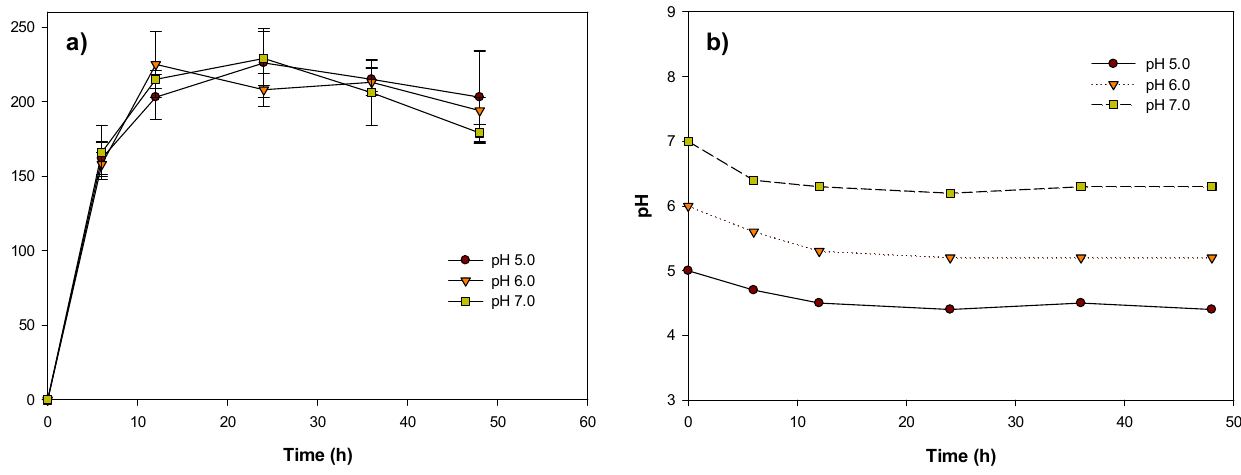
Figure 1. Effect of pH on H 2 O 2 generation: ( a ) H 2 O 2 generation with different initial pHs; ( b ) pH change with reaction time.